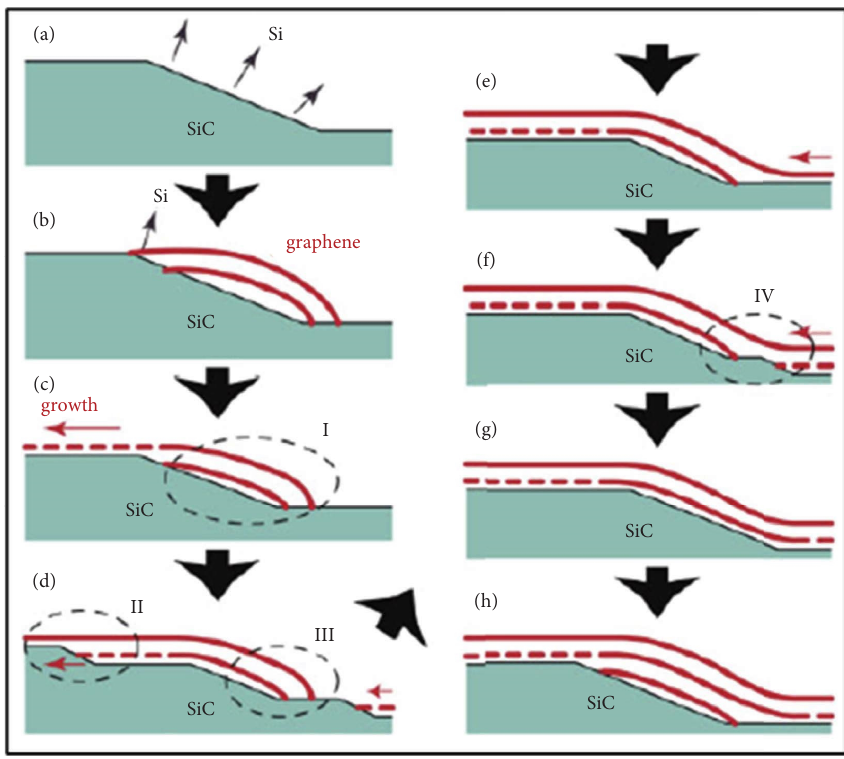
Figure 12: Graphene growth on silicon carbide (0001) surface [57].